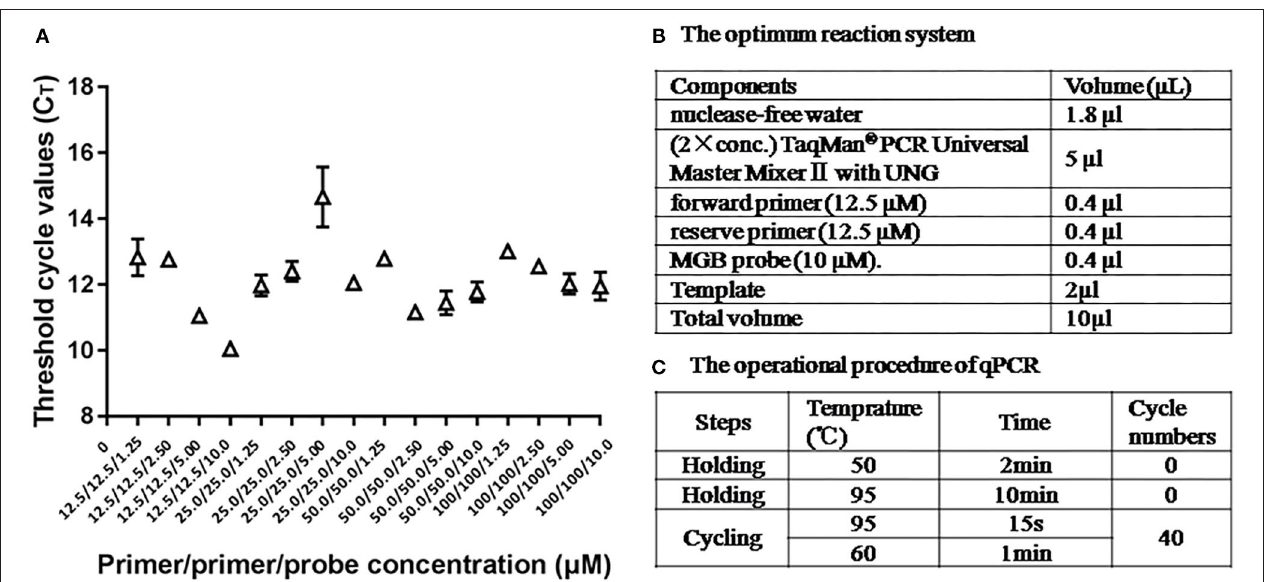
FIGURE 2 | Identification of target gene. (A) Target nucleotide sequences of MGB probe and primers for cdPCR within the conserved region of ASFV B646L gene. Forward primer was marked in orange, reverse primer was marked in red and the probe was marked in purple. (B) Amplification products were analyzed by agarose gel